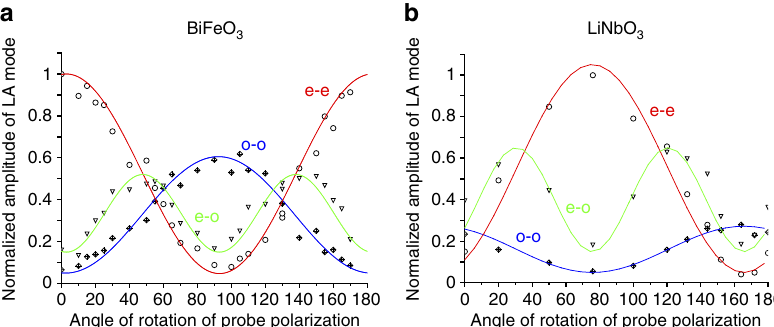
Figure 6 | Probe light electric field angle dependence of the Brillouin spectrum. Angle dependence ( y ) of the FFT amplitudes of the detected Brillouin modes corresponding to the processes (o)-(o), (e)-(e) and mode conversion processes (o)-(e)/(e)-(o) for ( a ) BFO and ( b ) LNO. The maximum amplitude is normalized to 1. The peak-to-peak amplitudes of each of these normalized curves are named A max in Table 1. The curves in full lines (red, blue and green) are fitted curves following squared cosinus or sinus functions in agreement with equations (5)–(8), see